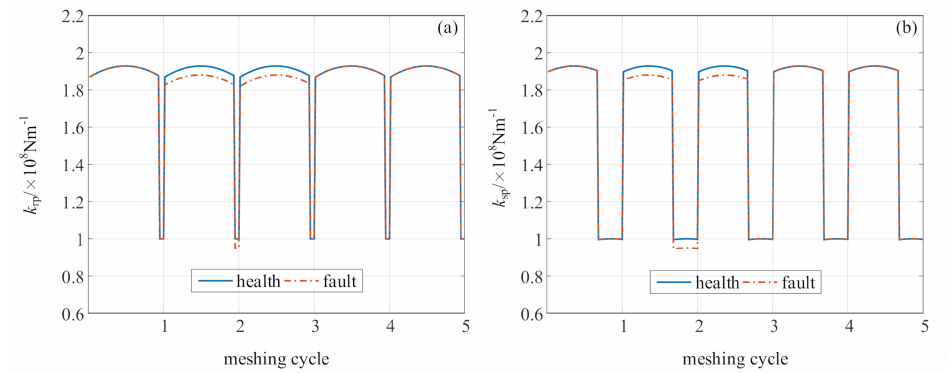
Figure 5. Meshing sti ff ness under health and fault condition: ( a ) ring-planet meshing and ( b ) sun-planet